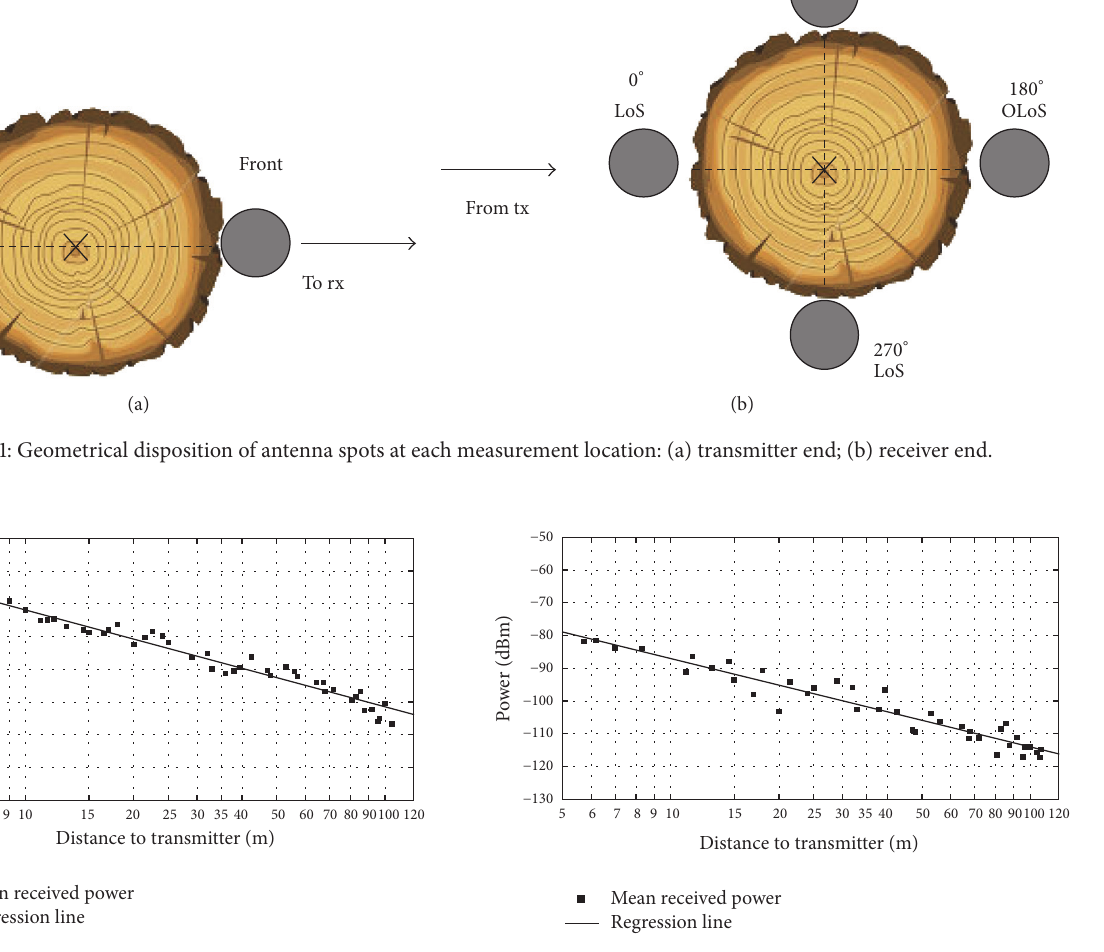
Figure 3: Pine tree, received power (dBm) versus distance in log- arithm axis, Tx front, and Rx angle